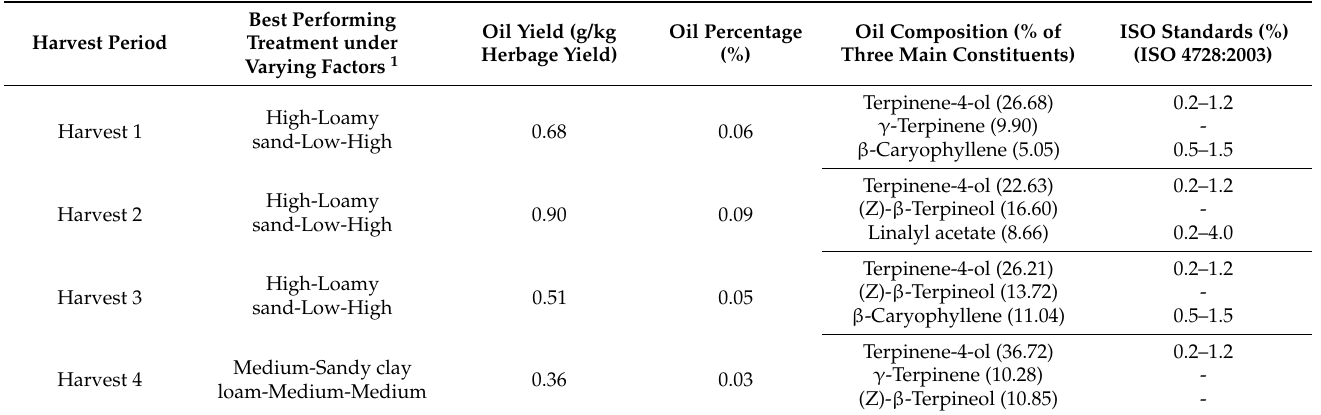
Table 9. Summary of oil yield, percentage, and composition of marjoram plants under varying air temperature and irrigation regimes, nitrogen application rate, and soil